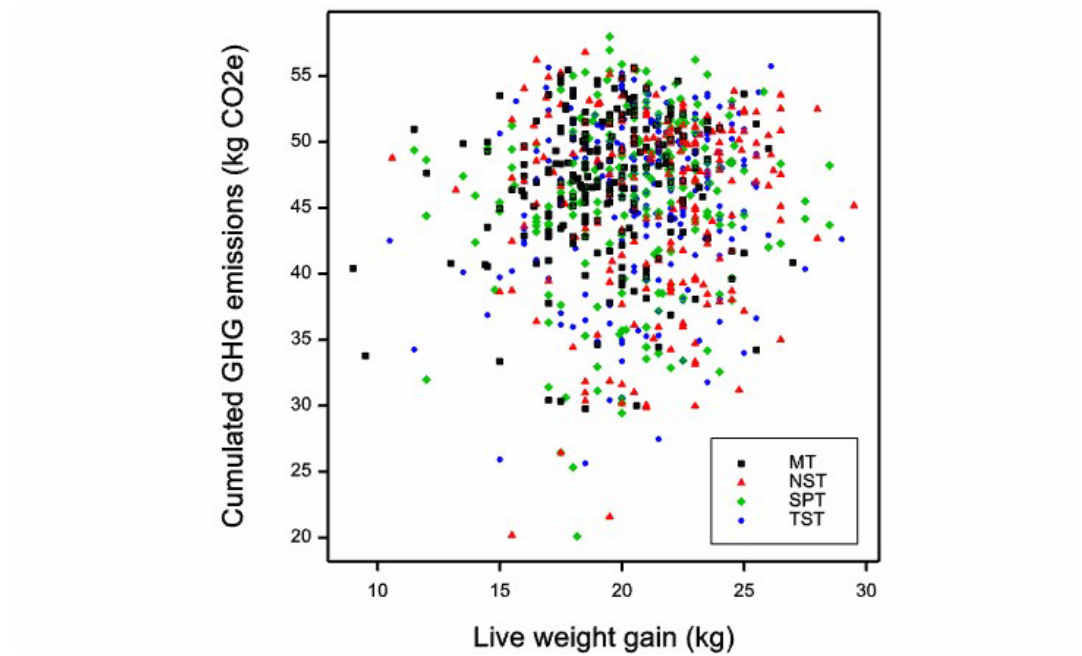
Figure 1. Cumulative GHG emissions associated with the weight gain of 830 lambs treated under the four anthelmintic regimes from 2006 to 2010, inclusive (with lambs either reaching the target slaughter weight or the end of the experimental period at 154 days).